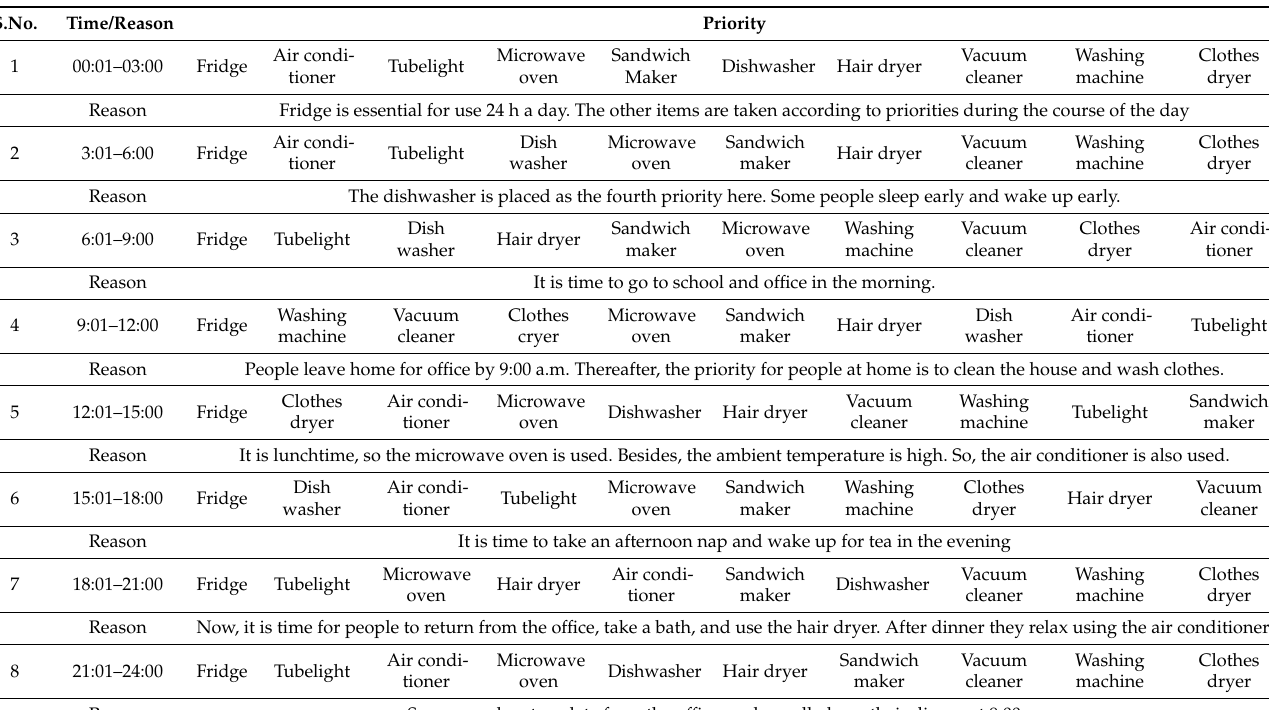
Table 2. Preference matrix for different devices.